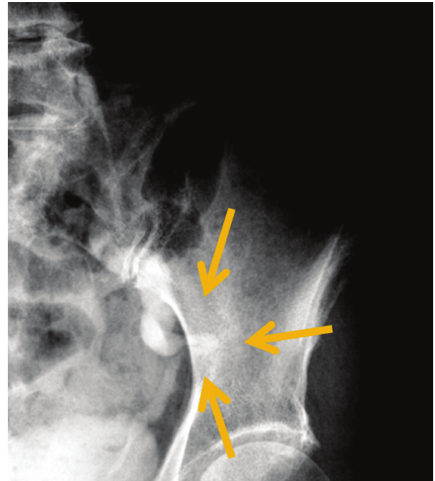
Figure 2: Drip infusion pyelography revealed “curlicue ureter” sign as the knuckle of the herniated ureter passed laterally to the medial wall of the bony pelvis